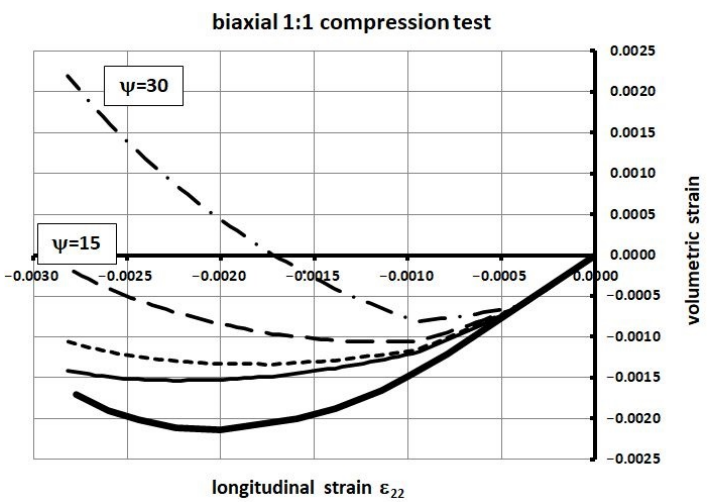
Figure 6. Volumetric strain vs. longitudinal strain for different dilatation angle values in the biax- ial 1:1 compression test.